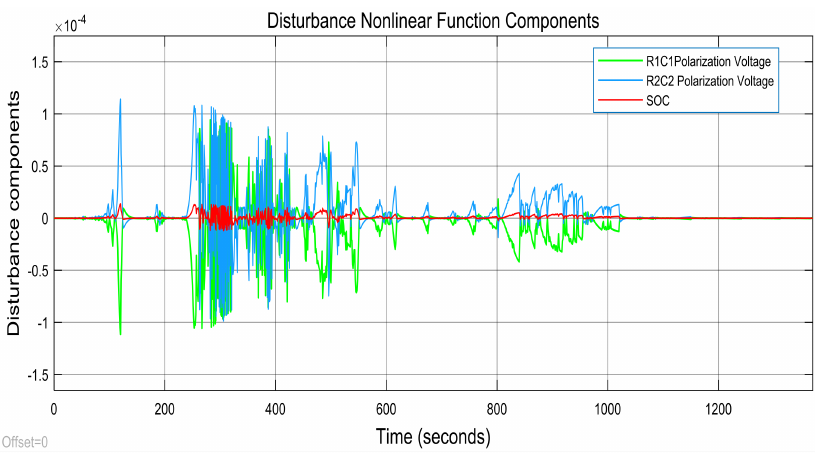
Figure 34. The slow disturbance nonlinear function components.